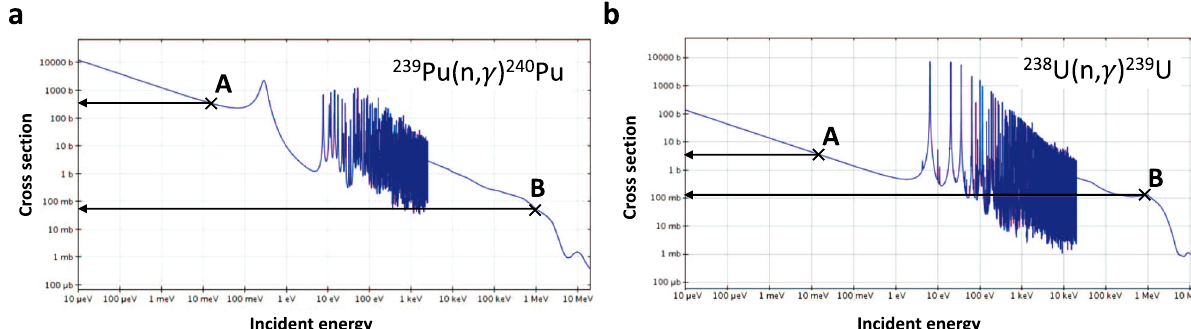
Fig. 5 Microscopic neutron cross sections. a For the production of 240 Pu via radiative neutron capture on 239 Pu, and b for the production of 239 U (and thus 239 Pu successive β decay) via radiative neutron capture on 238 U. Both plots have been derived using Janis 4.0 (see: https://www.oecd-nea.org/janis/). The labels ‘ A ’ denotes the cross section at thermal neutron energies and ‘ B ’ that at fast neutron energies (~1MeV) to illustrate the contrast in 240 Pu yield for fast and thermal neutron